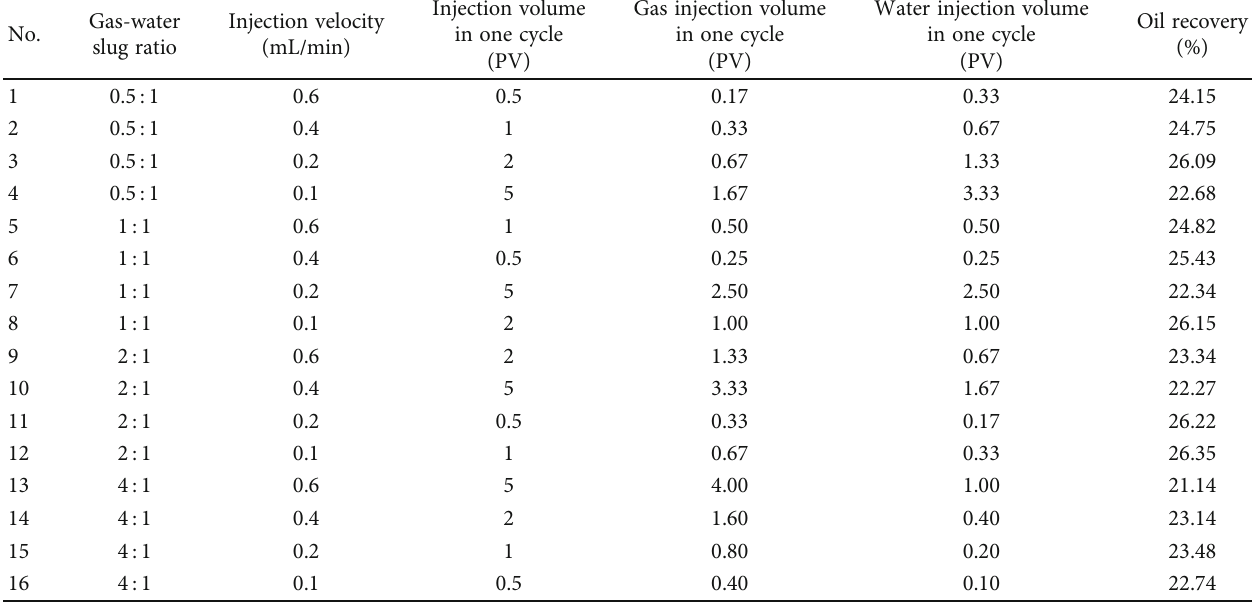
Table 4: Summary of orthogonal experimental design results.